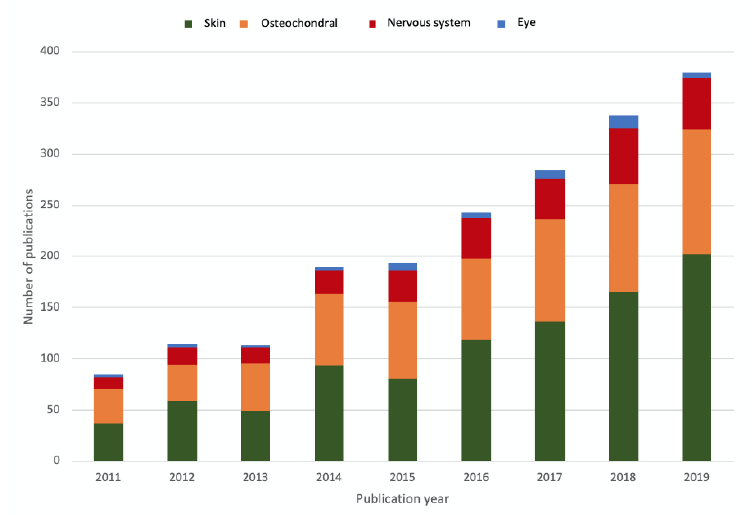
Figure 1. Number of publications per year (source: Scopus), showing the increased interest in the application of silk fibroin for different applications in tissue engineering (skin, osteochondral, nervous system, eye).